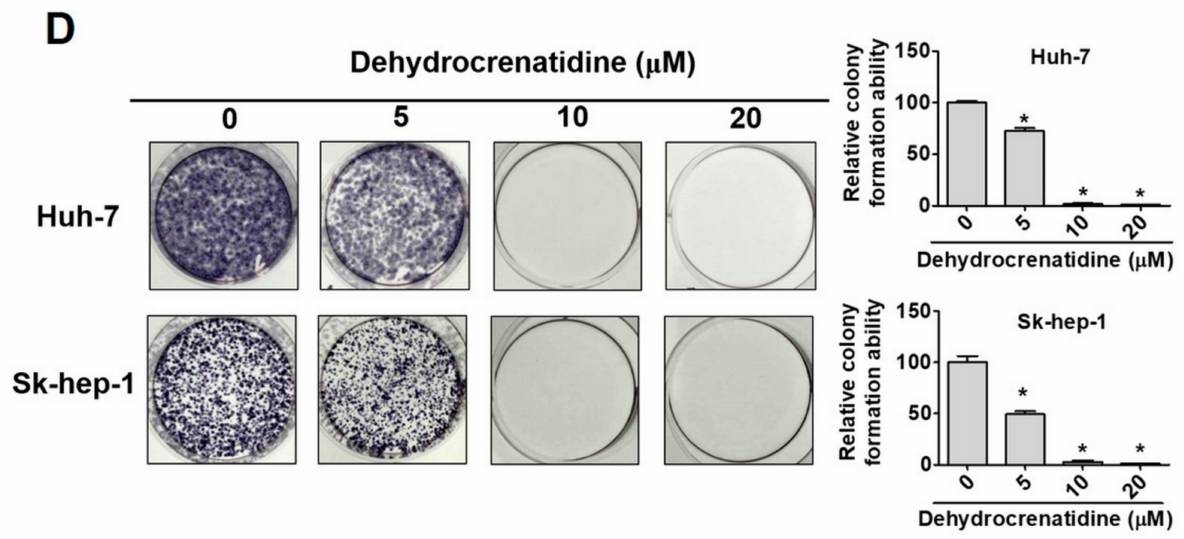
Figure 1. Dehydrocrenatidine induces cytotoxicity and inhibits in vitro cell survival in hepatoma cell lines. ( A ) The chemical structure of dehydrocrenatidine. The cell viability of ( B ) Huh-7 and ( C ) Sk-hep-1 were treated with indicated concentrations of dehydrocrenatidine (0, 5, 10 and 20 µ M) for 24, 48, and 72 h. ( D ) Cells that treated with indicated concentrations of dehydrocrenatidine (0, 5, 10 and 20 µ M) for 10 days were stained by Giemsa staining buffer. The formazan crystals of Huh-7 and Sk-hep-1 cells were quantified. Student’s t test was applied to determine statistical significance in experiment. * represented p < 0.05, compared with the control